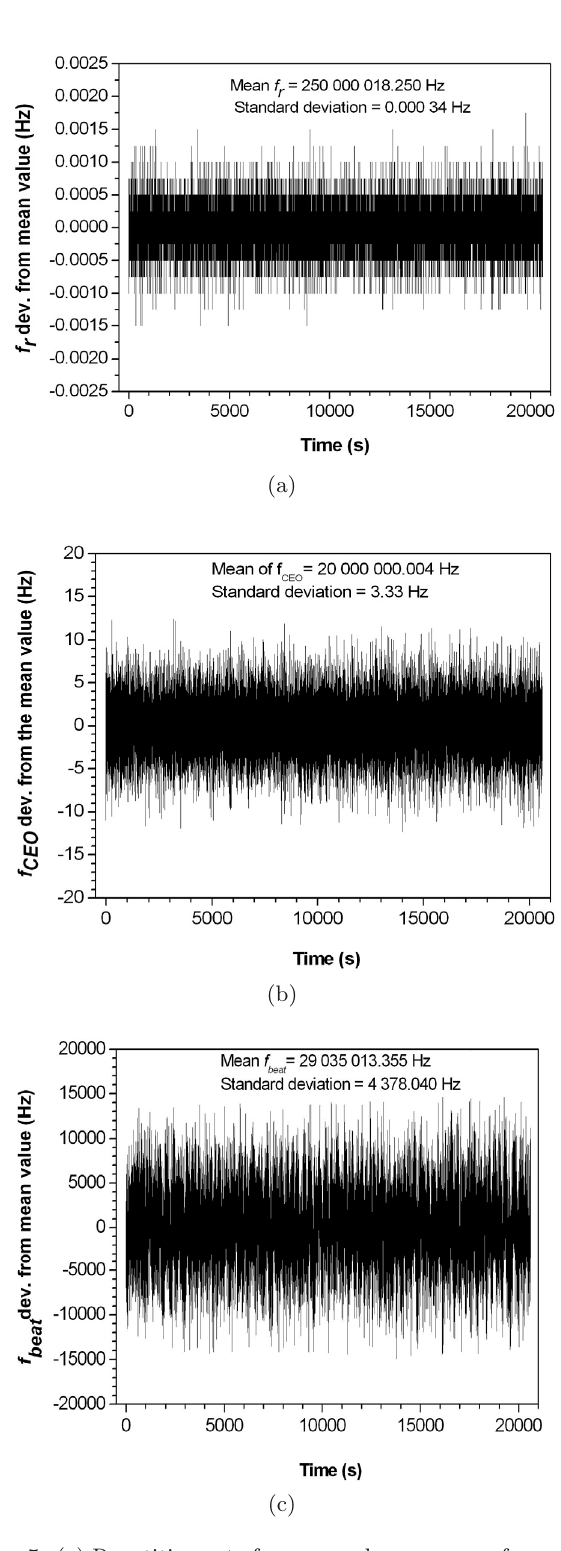
Fig. 5. (a) Repetition rate frequency shows a mean frequency of 250 000 018.250 Hz and a standard deviation of 0.000 34